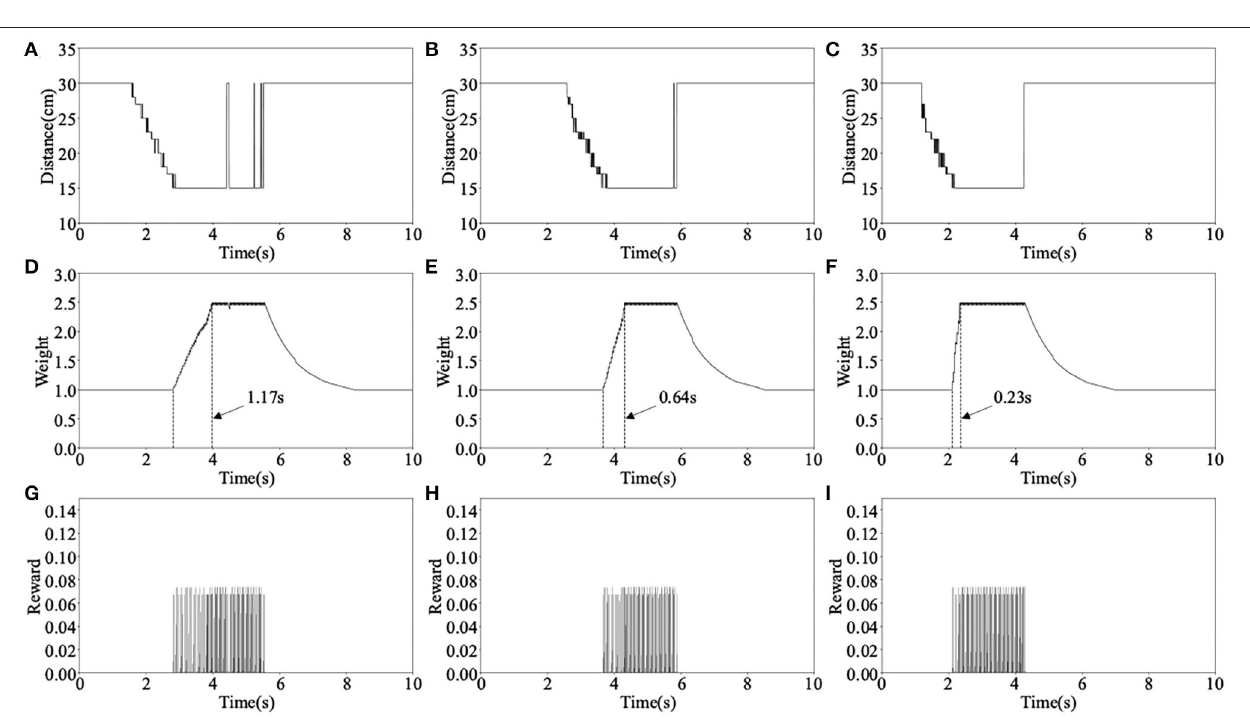
FIGURE 8 | The main parameters change in the first experiment, where (A–C) are the distance data measured by the left ultrasonic sensor, (D–F) are the synaptic weight of neurons N3 and N4, and (G–I) are the reward signals released by neuron R2.